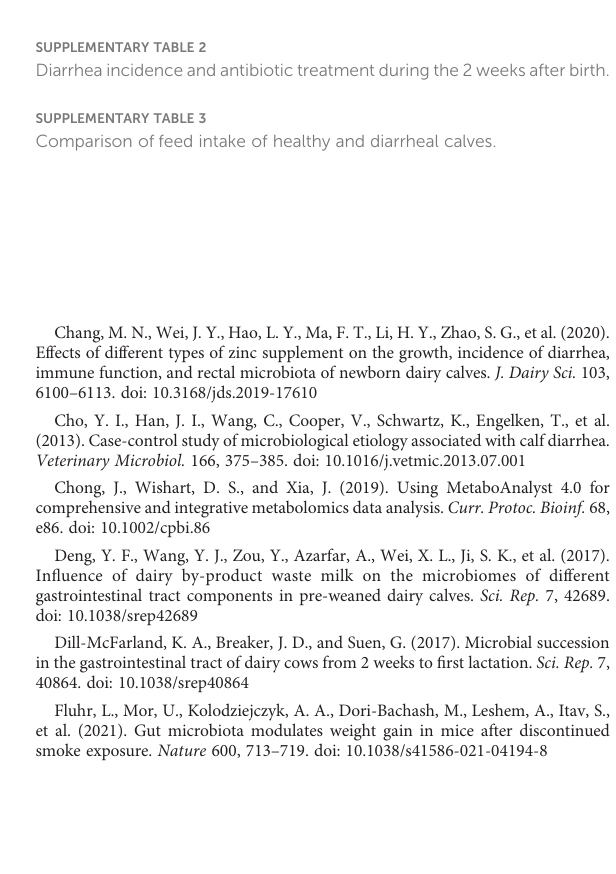
Comparison of feed intake of healthy and diarrheal